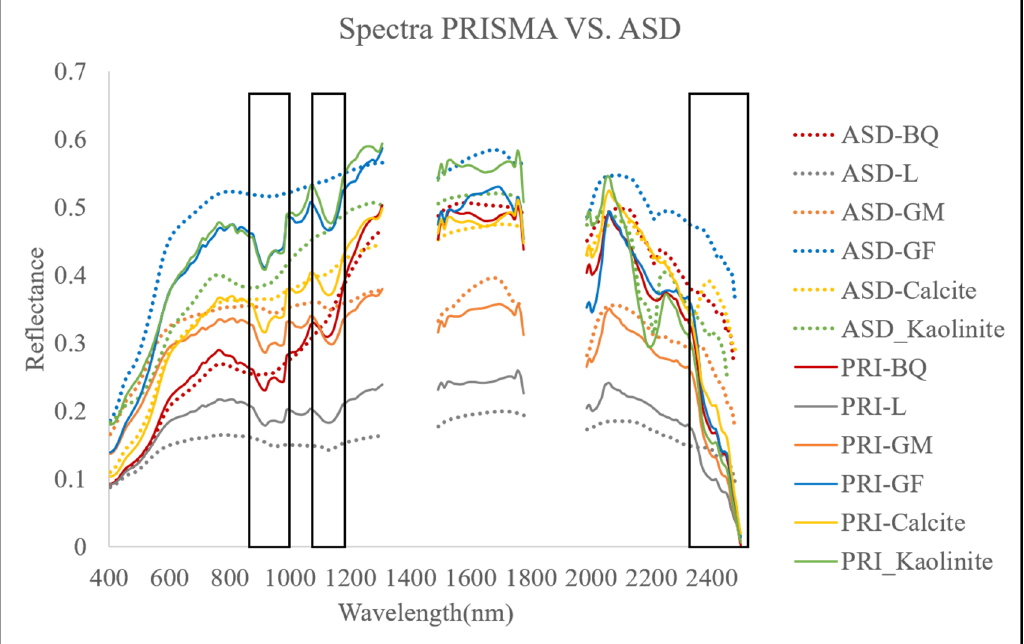
Figure 10. Evaluation of PRISMA L2D spectra (PRI) vs. ASD at the six test sites (PRISMA—solid line, ASD ground truth—dashed line). BQ, brown questa; L, laccolite; GM, gypsum—mine; GF, gypsum—fans.